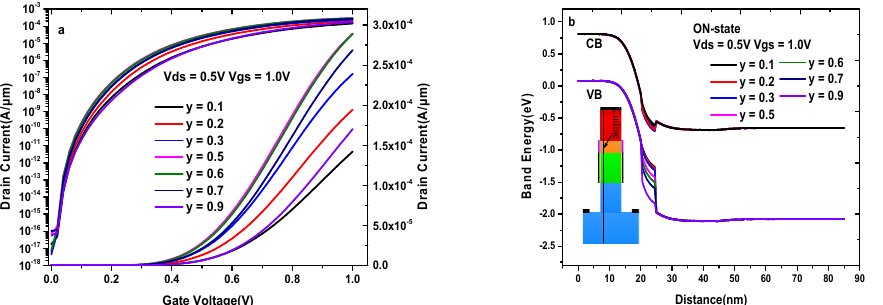
Figure 2. ( a ) The effects of composition changes in GaAsySb1-y on DMG-HD-VTFET transfer characteristics; ( b ) the ON-state energy band diagram of DMG-HD-VTFET with different composition of arsenic in GaAsySb1-y.